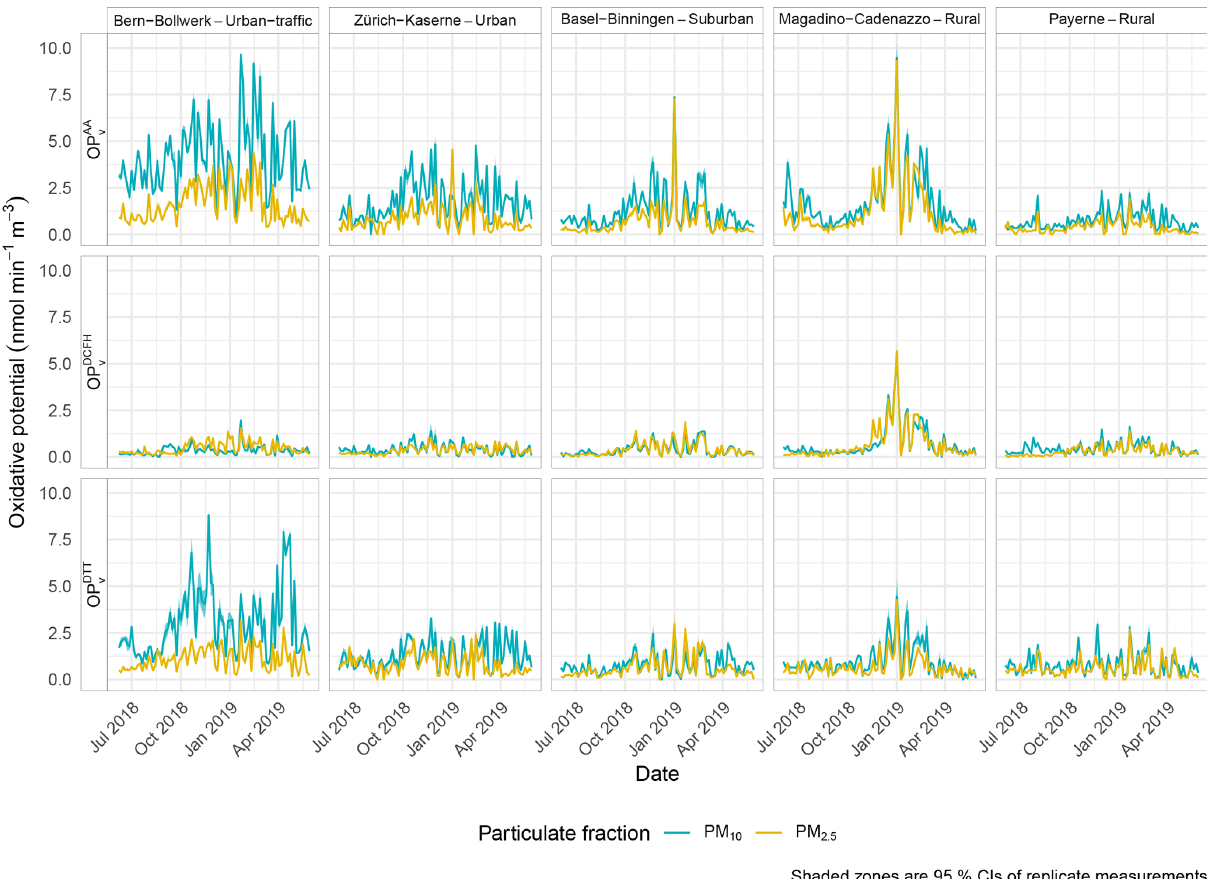
Figure A1. Time series of the three OP v assays for PM 10 and PM 2 . 5 at five sampling sites in Switzerland between June 2018 and May